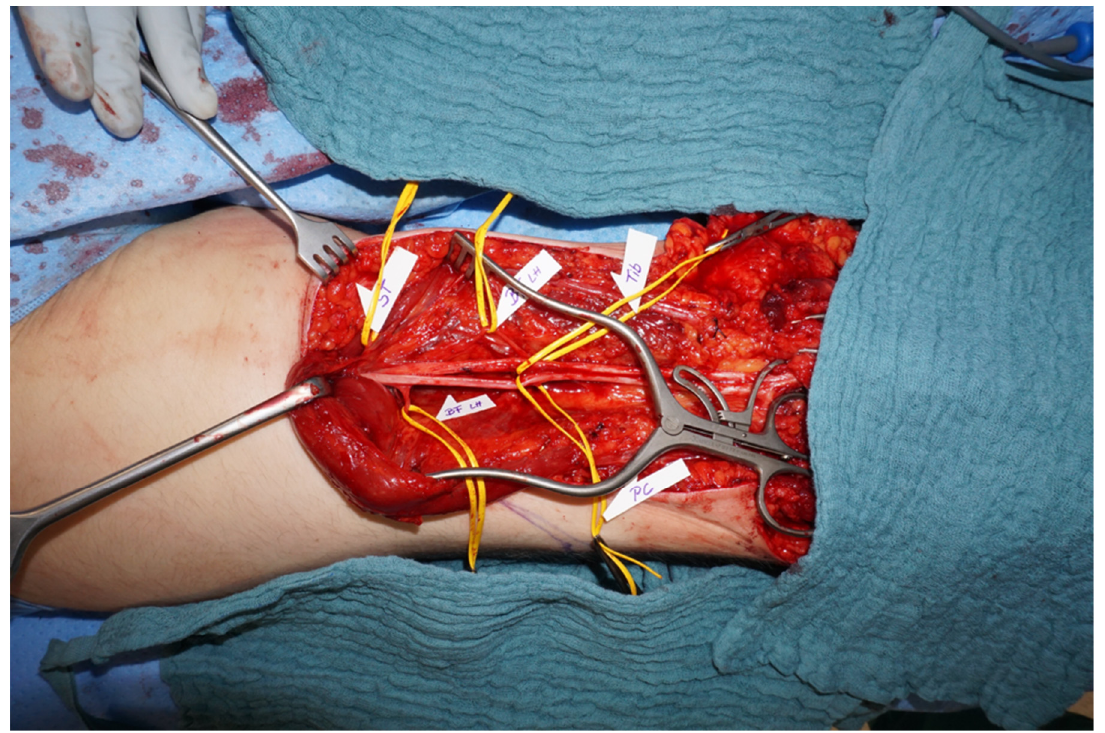
Figure 4. Amputation at above ‐ knee level was performed in combination with TMR. Individual nerve transfers are displayed in main text and Table 1.